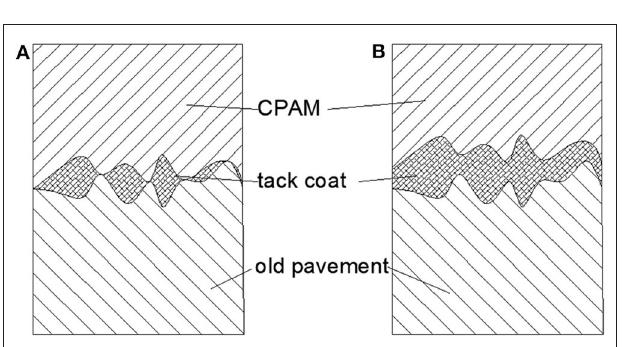
FIGURE 8 | The tack coat between CPAM and old pavement.